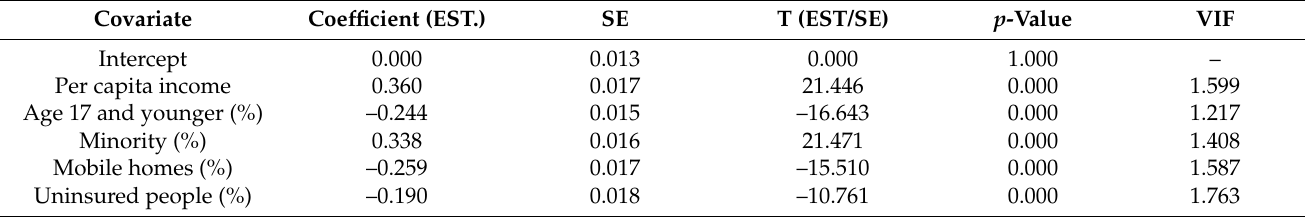
Table 3. Results of OLS model of COVID-19 vaccination rates in the United States.